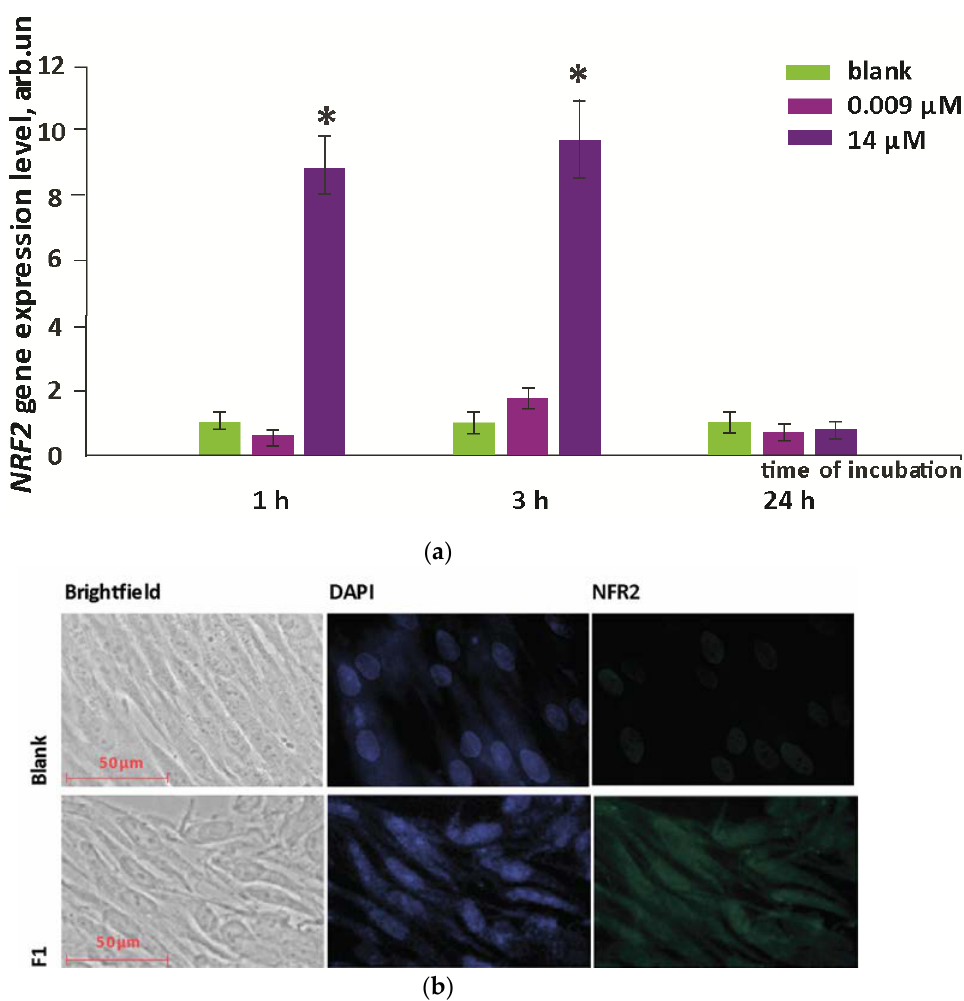
Figure 6. The NRF2 gene expression ( a ) in HELF cells incubated with F1 . The NRF2 RNA amount is a mean value from three experiments of NRF2 gene expression in the presence of F1 relative to the control value. TBP was used as an internal standard gene. Significant differences with the control by the Mann − Whitney test ( p < 0.01) are denoted by “*”. ( b ) Microscopy images at a magnification of 40×: (top to bottom) the control culture, cells after incubation with F1 (14.0 μM) for 24 h; (left to right) visible light, DAPI staining of nuclei (340–370 nm excitation filter, 420–470 emission nm), and fluorescence of antibodies to NRF2 (450–490 nm excitation filter (#4), 500–550 nm emission). Flow cytofluorimetry data were confirmed by fluorescence images. After 3 h, the NRF2 protein level increased by approximately 2-fold when F1 (14.0 μM) was added and by 1.5-fold after 24 h, with NRF2 localized in both nucleus and cytoplasm of the